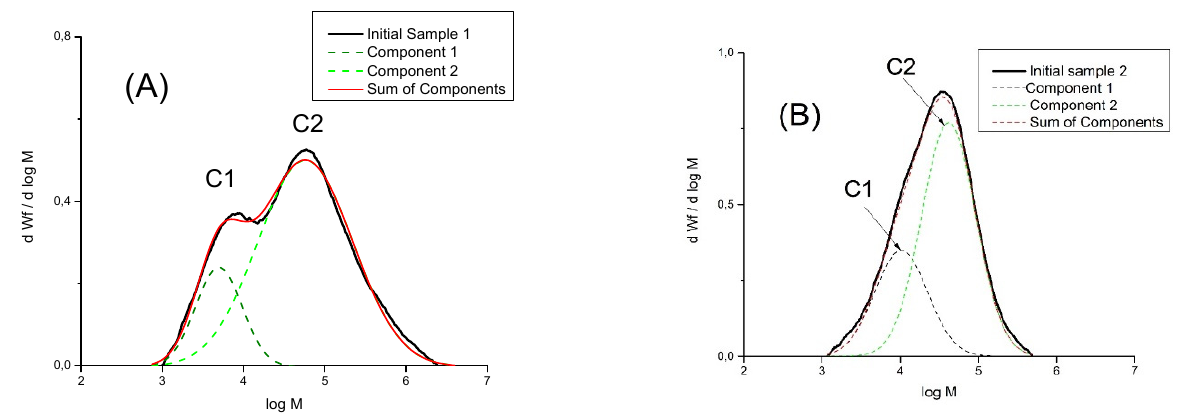
Figure 7. Data on the deconvolution of MWD curves of PE samples 1 and 2 obtained from ethylene polymerization in the absence of α -olefins ( A ) and from ethylene polymerization with hexene-1 ( B ). Data presented in Figure 7 and Table 4 show that the addition of hexene-1 into eth- ylene polymerization leads mainly to a decrease in the M w value for the high-molecular-mass part C2 for sample 2 in comparison with sample 1 (from 130 kg/mol